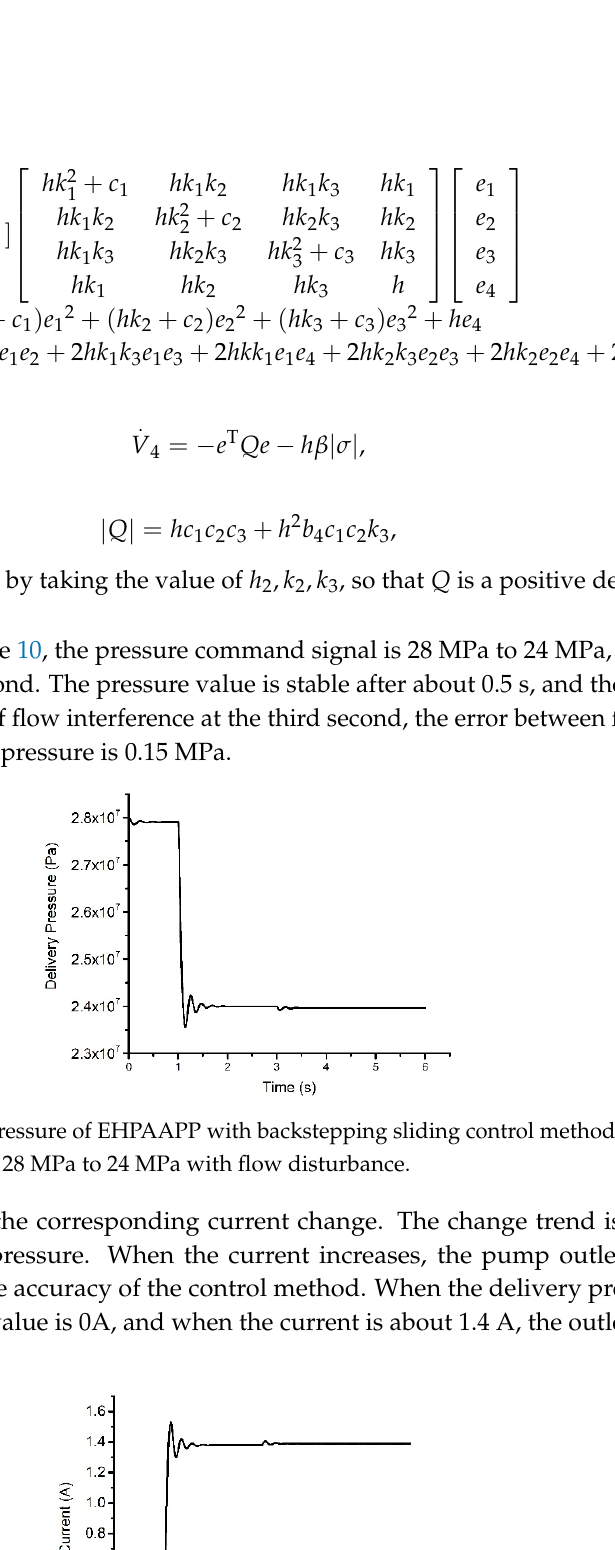
Figure 11. Current Response of EHPAAPP with backstepping sliding control method in the case of input signal change from 28 MPa to 24 MPa with flow disturbance.